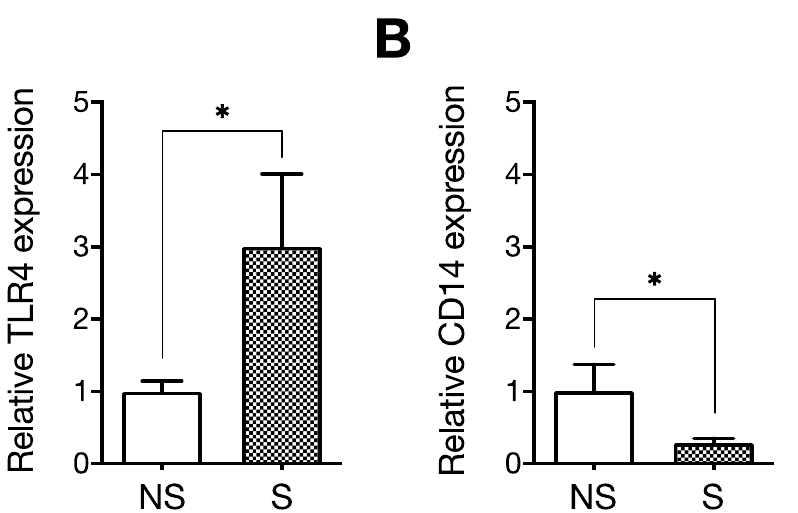
Figure 4. The expression of TLR4 and CD14 in senescent endothelial cells. Flow cytometry was used to analyze the expression of TLR4 and CD14 in senescent (S) and non-senescent (NS) human umbilical vein endothelial cells (HUVECs). The relative expression of TLR4 ( A ) and CD14 ( B ) of senescent cells was expressed as a ratio to non-senescent cells. Data are the mean ± standard deviation (SD) of at least three independent experiments. Values were compared between senescent and non-senescent cells. The expression of TLR4 was upregulated, whereas the expression of CD14 was downregulated in senescent cells. * p < 0.05 [93].